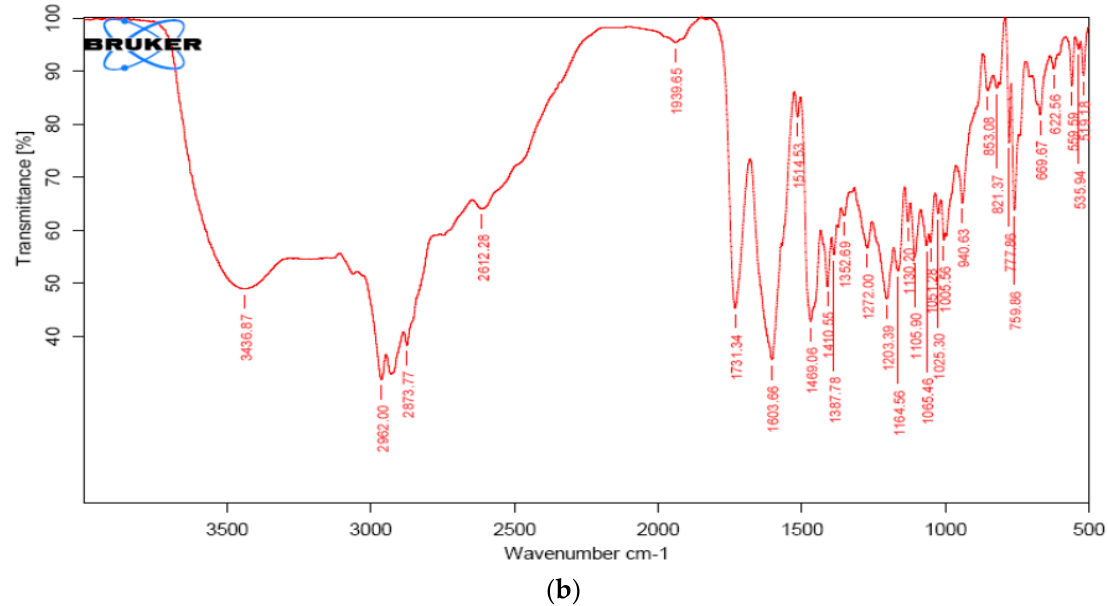
Figure 1. FTIR Spectrum of ( a ) pure VS and ( b ) physical mixture of VS formulation. Table 1. Characteristic peaks and the possible group assigned for different samples. Sample